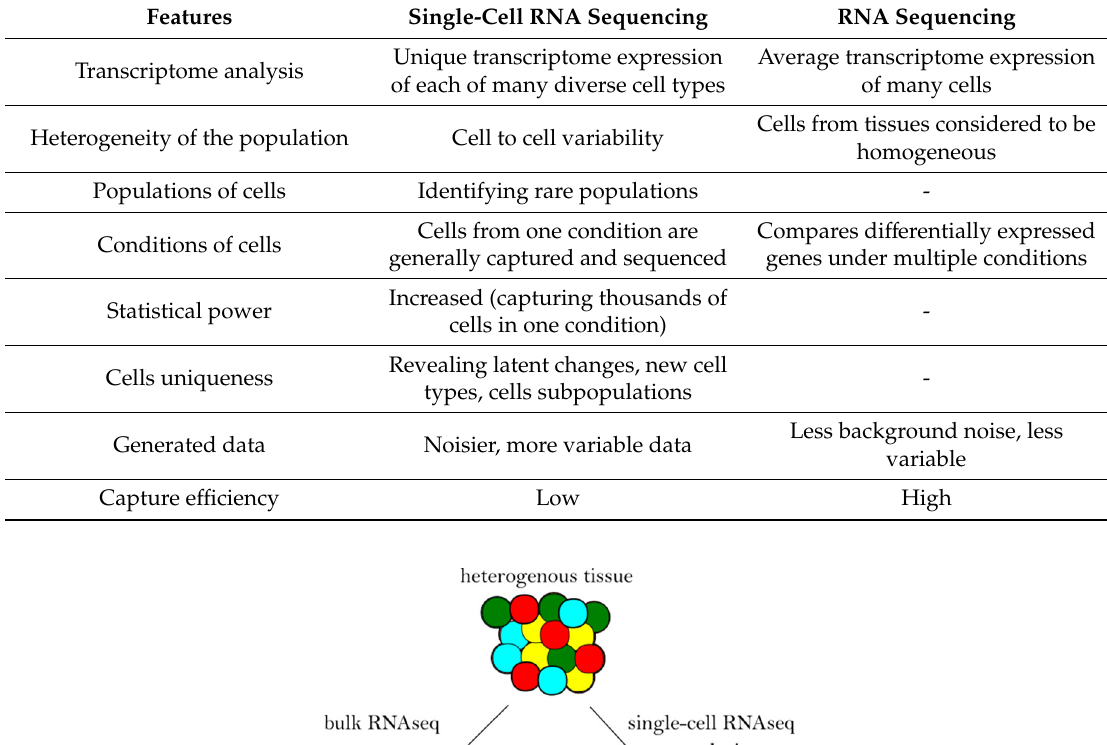
Table 1. Comparison of RNA sequencing methods.